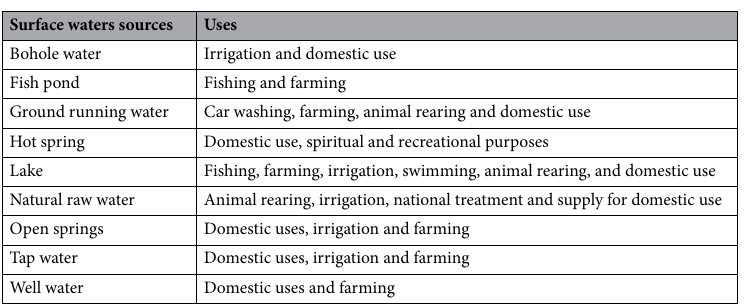
Table 3. Surface waters sources sampled in the districts. Author compilation as found in the